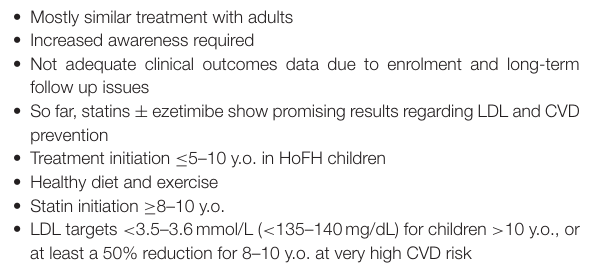
Box 2 | Summary of pediatric FH